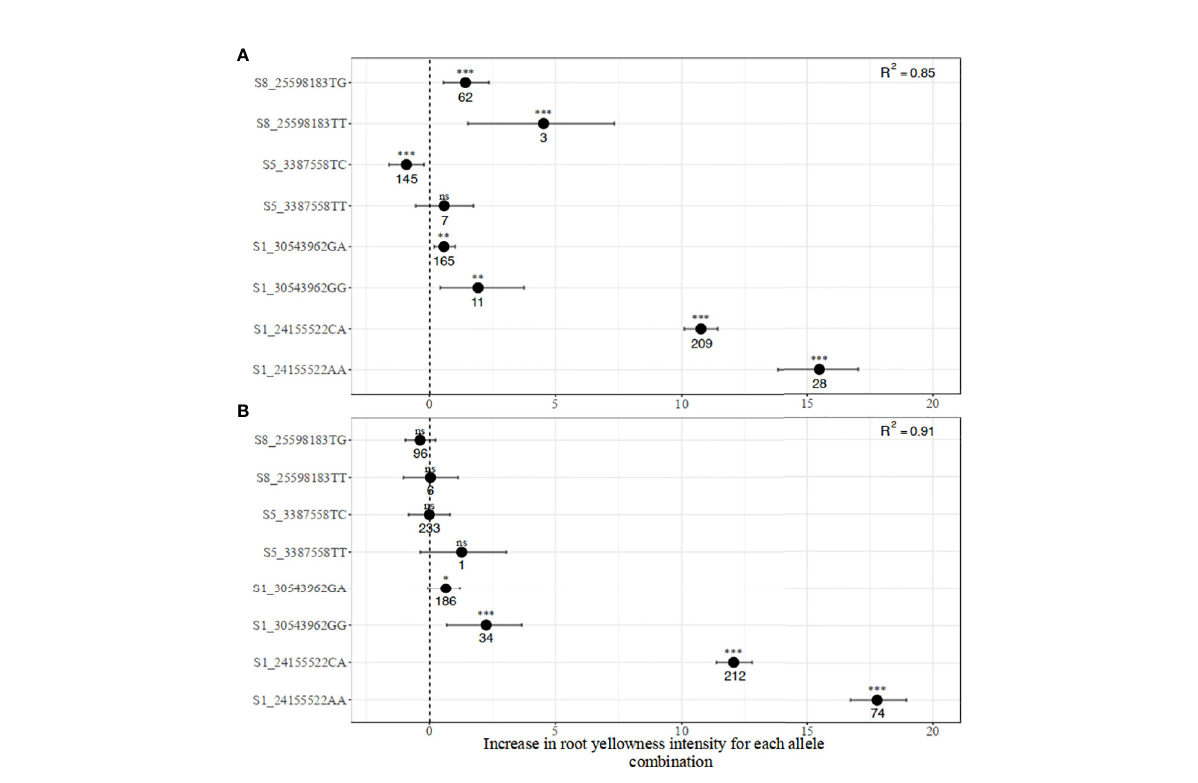
FIGURE 5 Distribution of marker allelic effects associated with increased carotenoid content in (A) breeding, and (B) pre-breeding